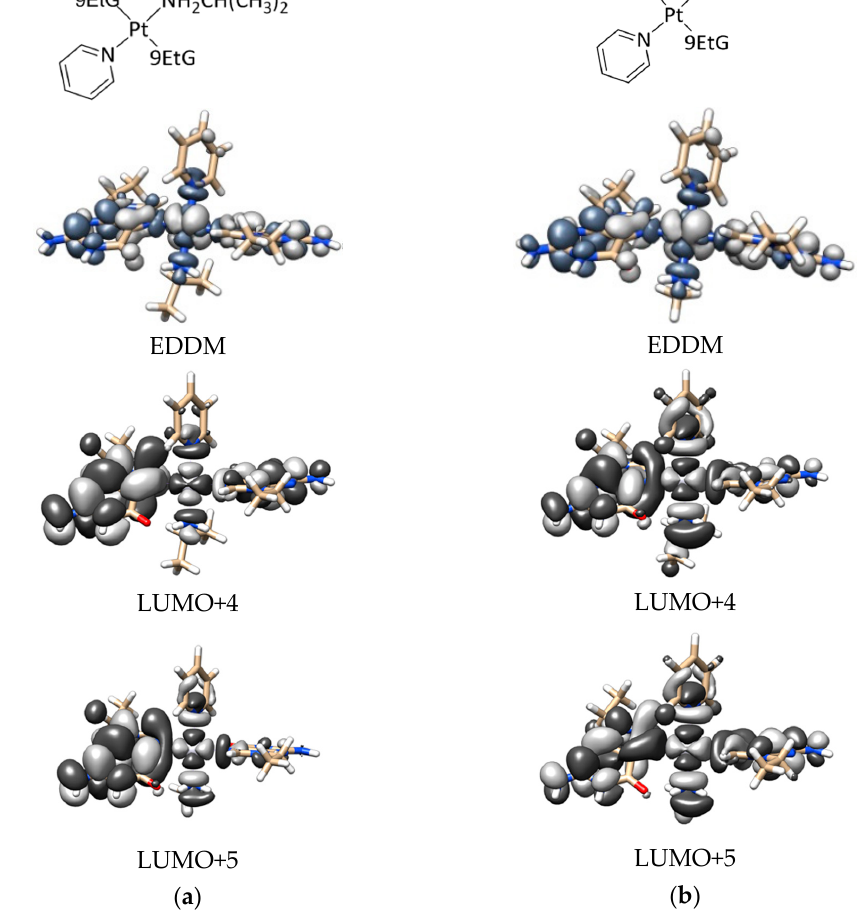
Figure 6. Selected electron difference density maps (EDDMs, transition 1, Table S7) and corresponding LUMOs for the bis 9 ‐ EtG adducts of complexes 1 ( a ) and 2 ( b ) in water at the CAM ‐ B3LYP/LANL08/6 ‐ 31G** level. In the EDDMs (top), gray indicates a decrease in electron density, while blue–gray indicates an increase.